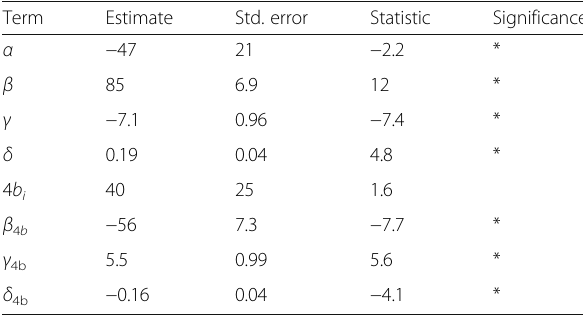
Table 4 Growth curve analysis